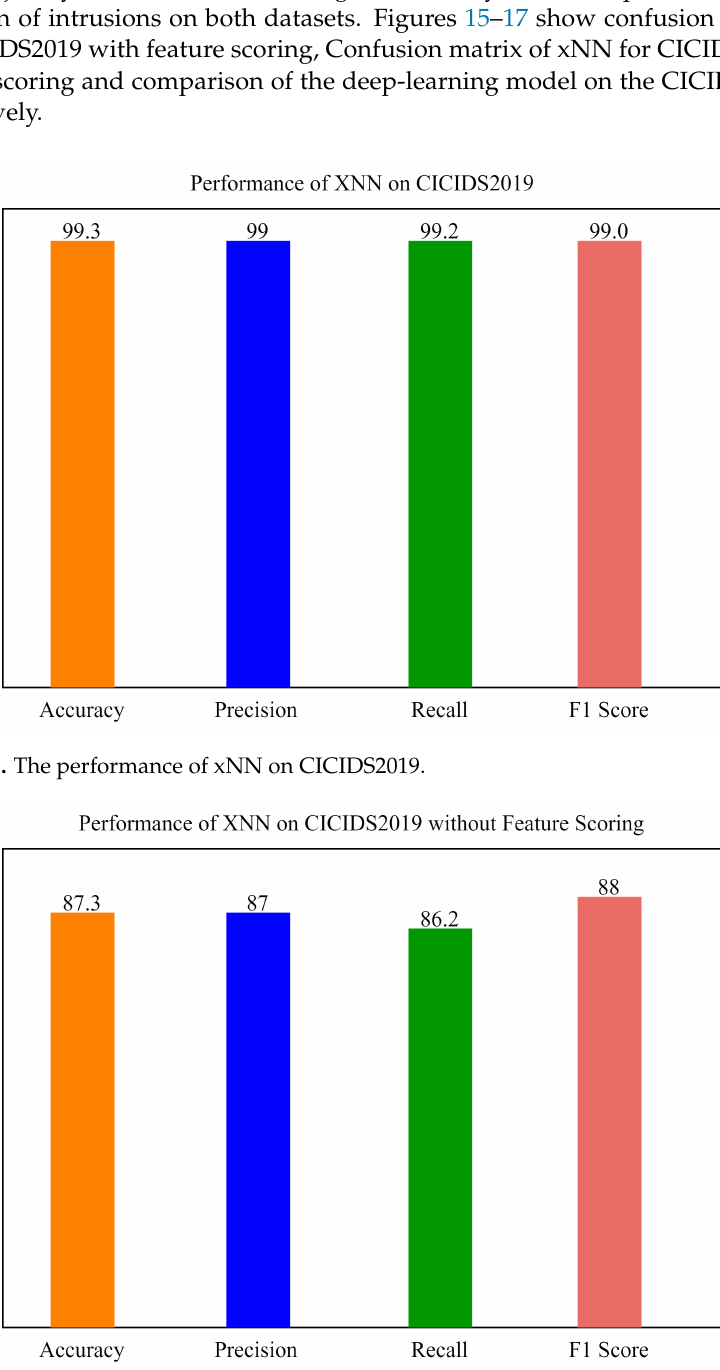
Figure 14. The performance of xNN on CICIDS2019 without feature